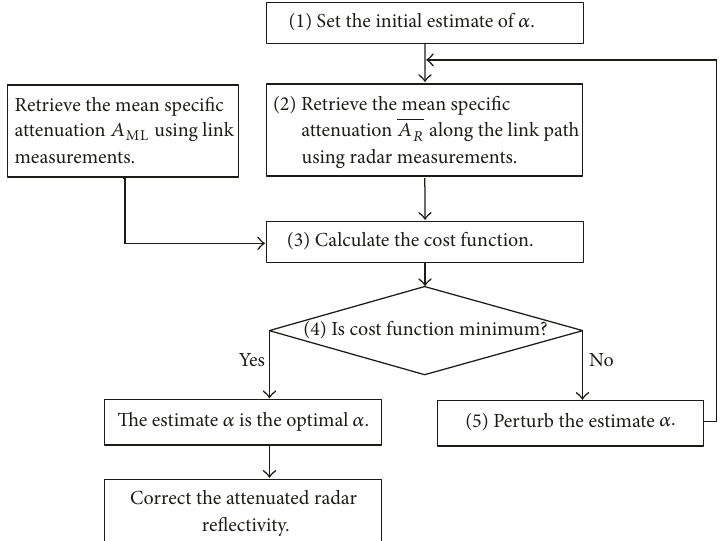
Figure 1: The flow schematic diagram of the optimization and correction